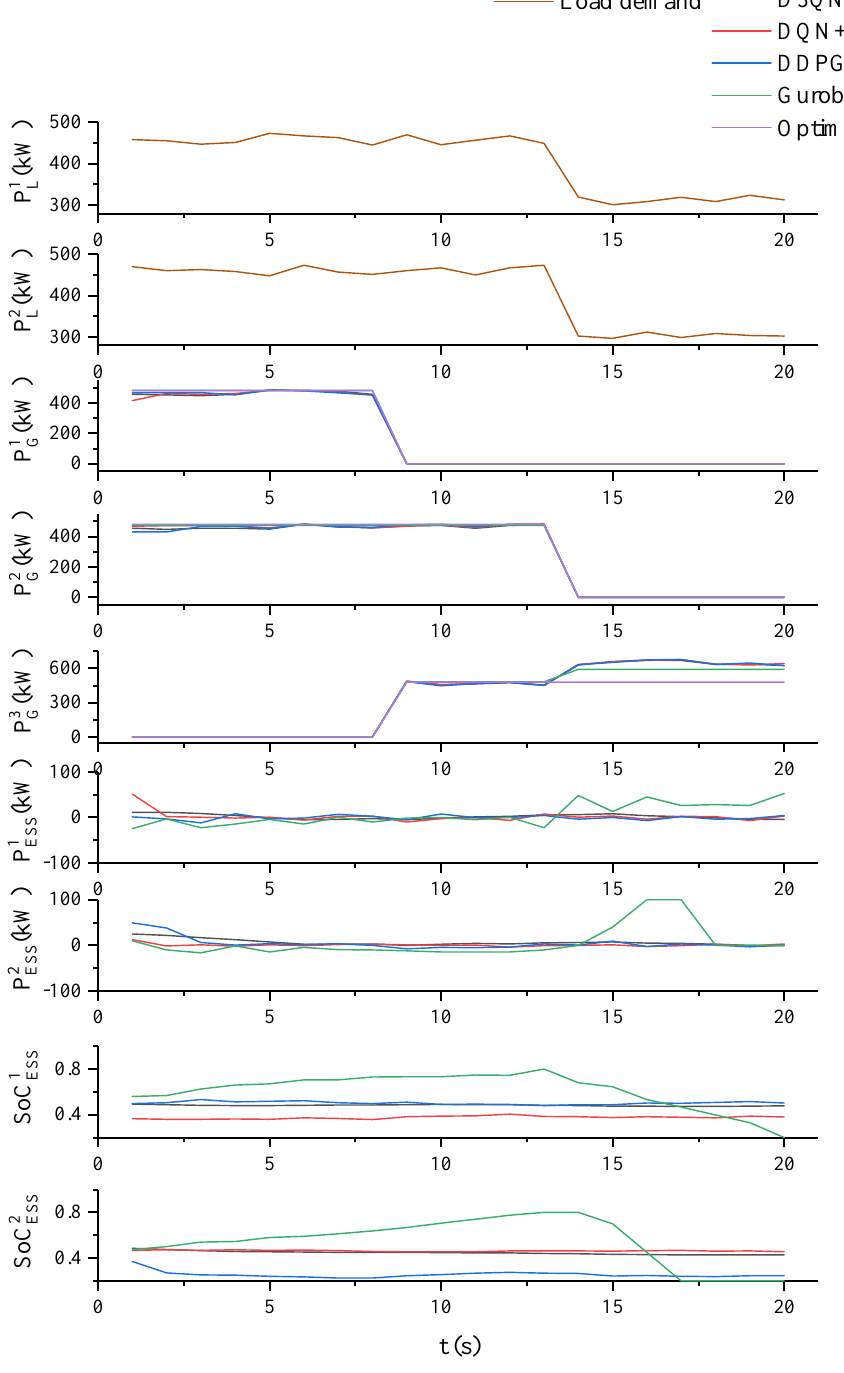
Figure 9. Condition 3 (main generator are